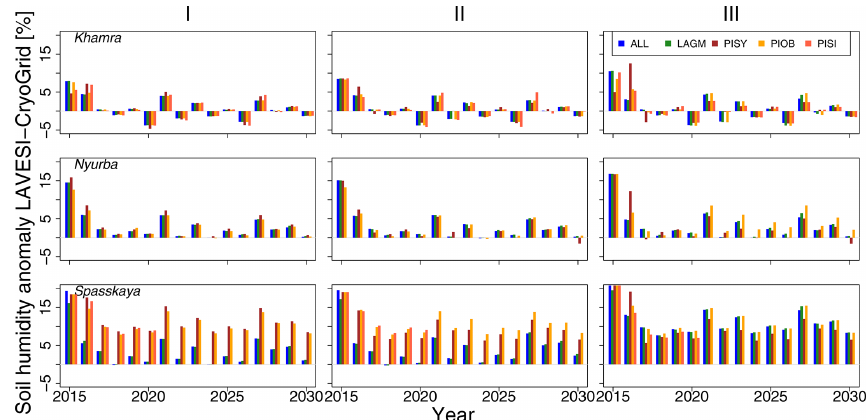
Figure 4. Soil moisture anomalies in the coupled simulation model for all focus areas (rows) and areas within the simulation areas (columns: